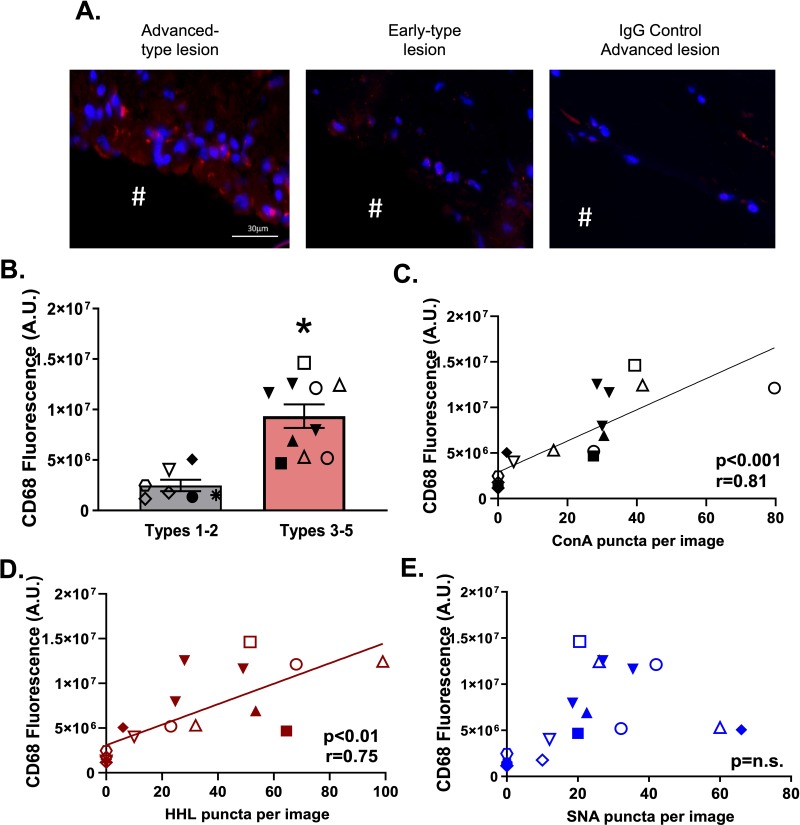
CD68 macrophage staining positively correlates with HM / hybrid ICAM-1 in human atherosclerosis.Panels A and B show representative images and quantitation, respectively, of CD68 staining in advanced and early type lesions, as well as IgG control staining. Data are mean ± SEM, n = 7–10 * p<0.05 compared to types 1–2 via unpaired t-test. C-E. ConA, HHL, and SNA puncta plotted against CD68 staining. Data are from n = 17 vessel samples collected from 12 subjects; each symbol represents a different subject. Best fit lines were determined by linear regression analyses indicated coefficients determined by Pearson correlation analyses.